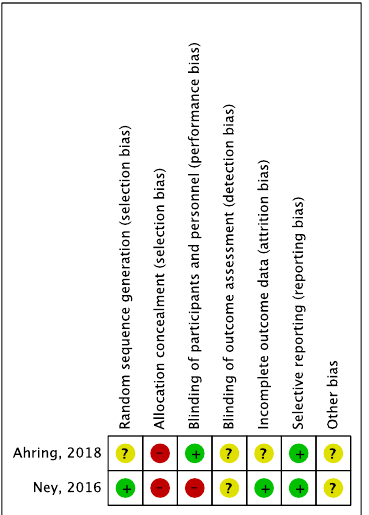
Figure 2. Risk of bias summary across randomised controlled trials. Low risk of bias: green “+”; Unclear risk of bias: yellow “?”; High risk of bias: red “−”.